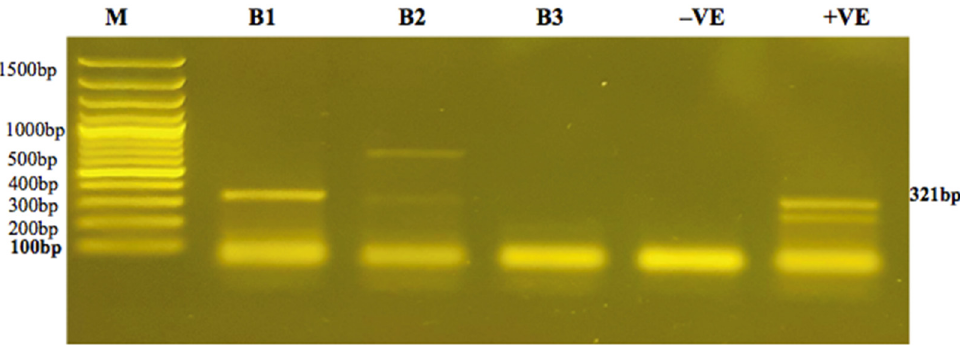
Figure 2. The expression of infection on PCR in experimental rabbits. Lane M: molecular weight marker of 100 bp, Cat. # SM0323; lanes B1–B3: rabbit blood samples; lane − VE: DEPC water; lane +VE: positive control of B. bigemina, 321 bp (Animal Disease Research Unit and Department of Vet- erinary Microbiology and Pathology, Washington State University).